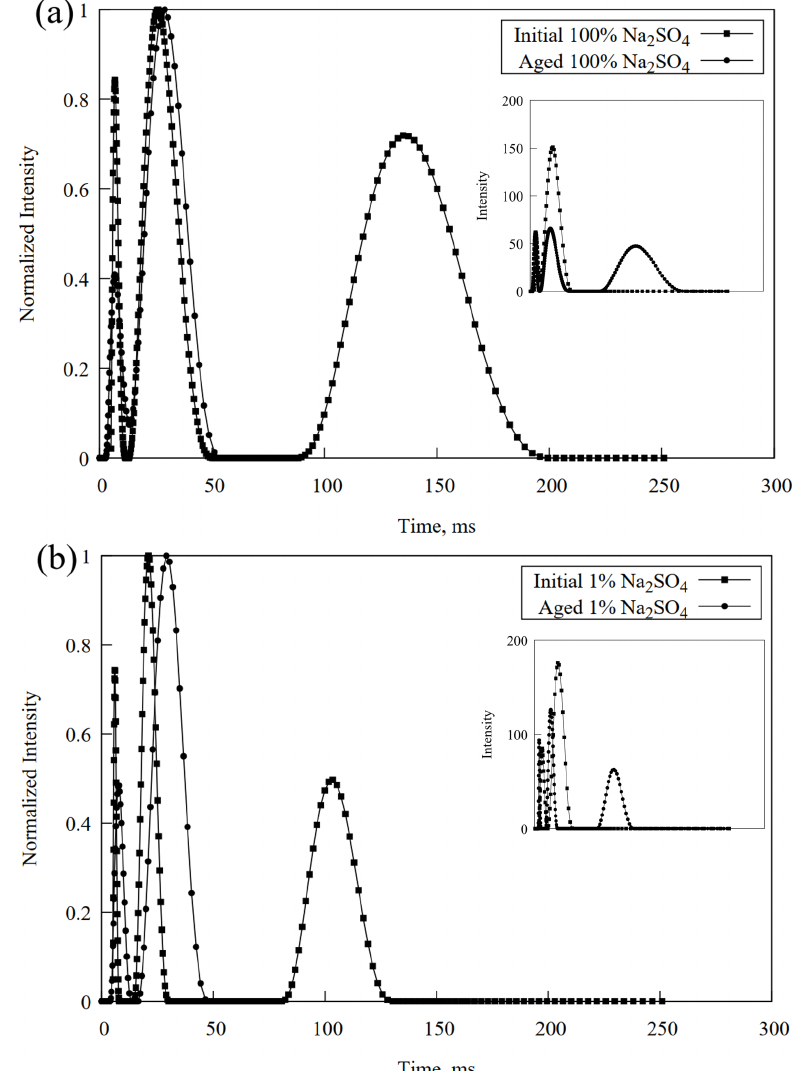
Figure 14. ( a ) Relaxation time distribution (T 2 ) of Berea Sandstone initially saturated with crude oil and then aged in 100% Na 2 SO 4 ; ( b ) Relaxation time distribution (T 2 ) of Berea Sandstone initially saturated with crude oil and then aged in 1% Na 2 SO 4 . The diffusion coefficient, shown in Figure 15, increases for both systems, from 0.053 ± 0.002 × 10 − 9 m 2 /s to 0.407 ± 0.002 × 10 − 9 m 2 /s for 100% Na 2 SO 4 and from 0.050 ± 0.002 × 10 − 9 m 2 /s to 0.321 ± 0.002 × 10 − 9 m 2 /s for 1% Na 2 SO 4 , respectively. The lower